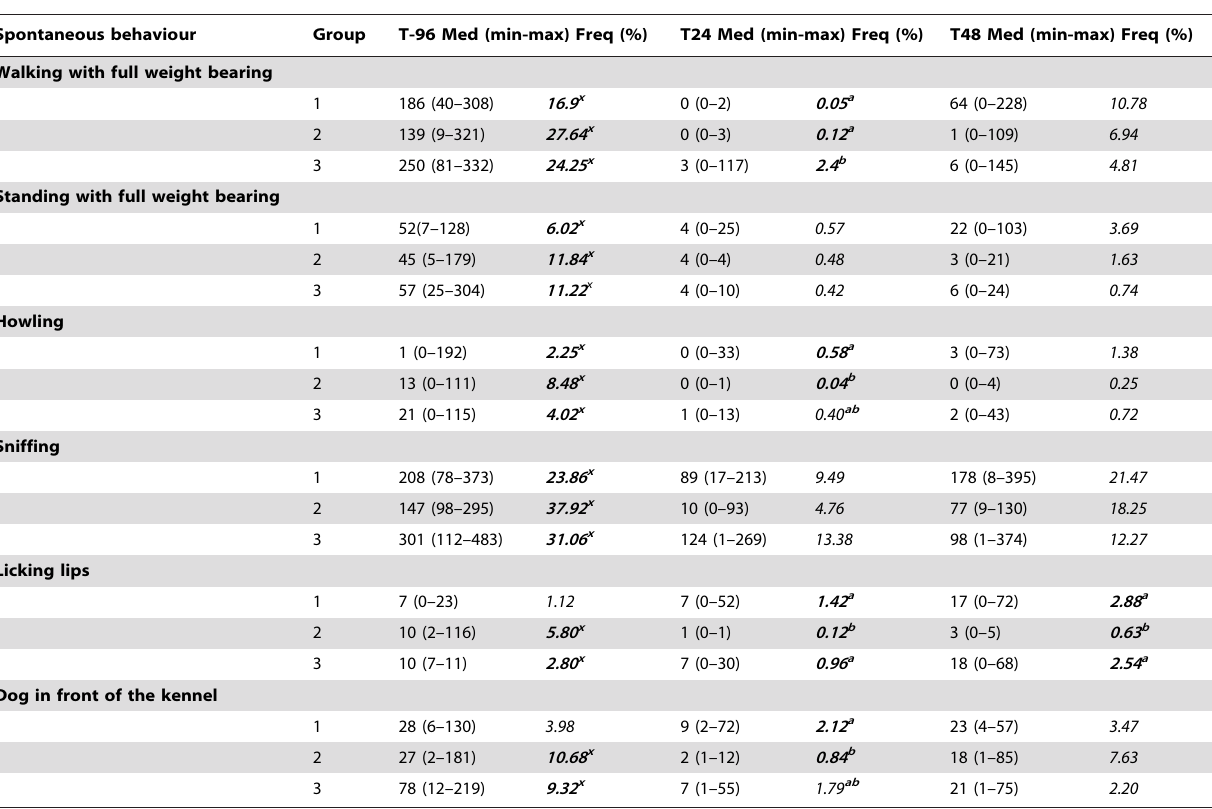
Table 3. Descriptive statistics of spontaneous behaviour during video-analysis.